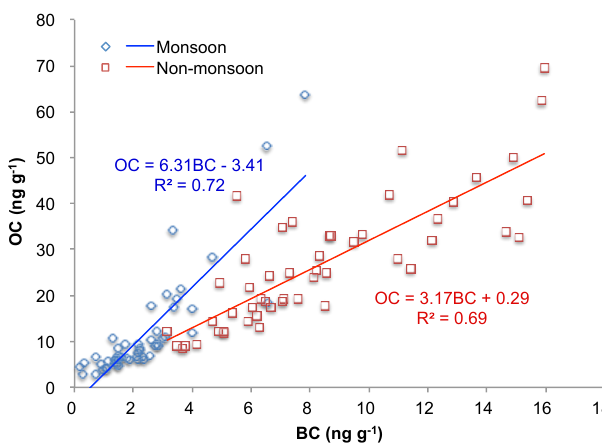
Figure 3. Scatterplots for yearly monsoon and non-monsoon mean OC and BC concentrations during 1956–2006, obtained from the ice-core measurements, and corresponding linear